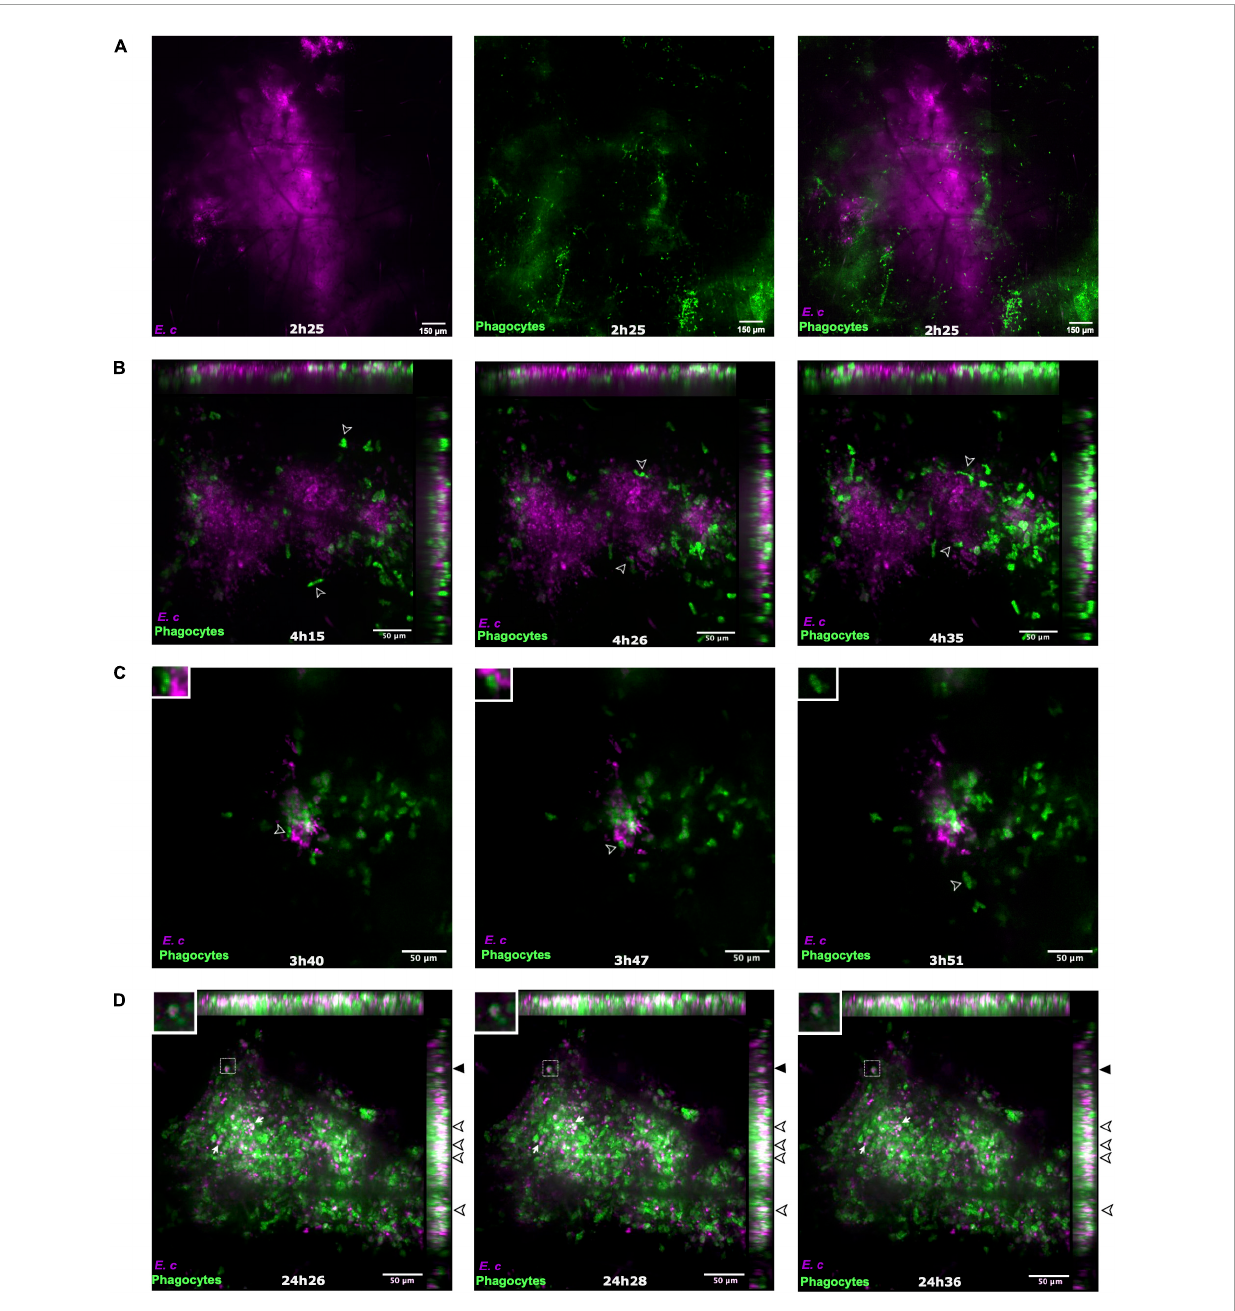
FIGURE3 Dynamics of recruited EGFP + cells in the mouse ear pinna after inoculation of Encephalitozoon cuniculi spores. Live confocal imaging after micro-injection of E. cuniculi spores in the ear pinna of LysM-EGFP transgenic mice from 2 h to 25 h pi (A–D) . The recruited EGFP + phagocytic cells progressively infiltrate the injection area (A) and come into contact with CW + parasites at the injection site [ (B) , empty arrowheads follow the same cell over the course of the acquisition]. Different cell behaviors are observed, an "arrested" (B) and a "quick” phenotype. The “quick” phenotype corresponds to cells that interact shortly with parasites and rapidly leave the injection area [ (C) empty arrowhead and inset]. Live confocal imaging at later time points after micro-injection of E. cuniculi spores (D) . White arrows and empty arrowheads indicate the presence of numerous remaining parasites after 24 h. Inset and filled black arrowheads show the decrease of the CW fluorescence signal inside an EGFP + phagocyte during the video acquisition time, in favor of parasite phagocytosis and lysis inside the cell (D) . (A–D) Images show average intensity projections of green (phagocytes) and blue (parasites) fluorescence. Some intracellular parasites appear in white [overlap of green and blue fluorescent signals, empty arrowheads, (D) ]. 4 independent experiments, n = 8 tissues ( E. c ) and n = 14 control tissues (PBS). Scale bar: 50 µ m.